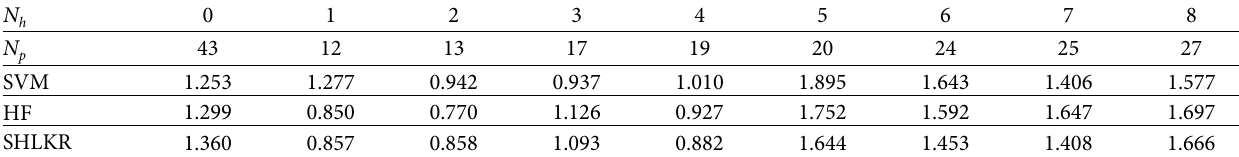
Table 4: MAE comparison using different number of historical